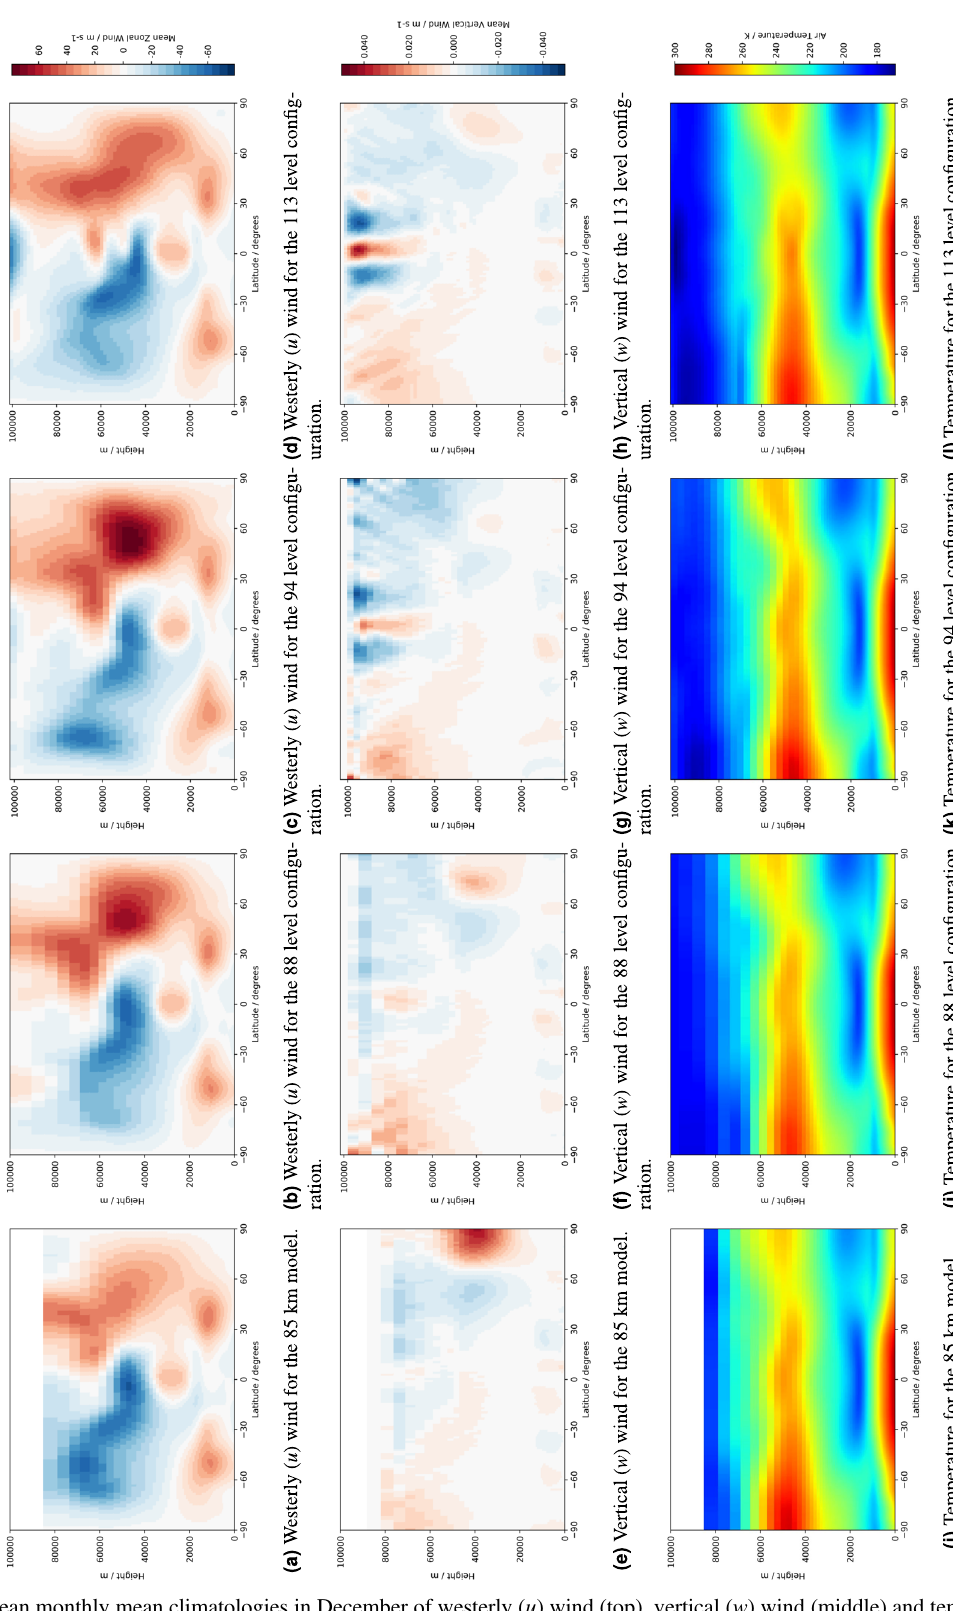
Fig. 12. Zonal mean monthly mean climatologies in December of westerly ( u ) wind (top), vertical ( w ) wind (middle) and temperature (bottom) comparing the original 85 km model with the 88, 94 and 113 level con fi